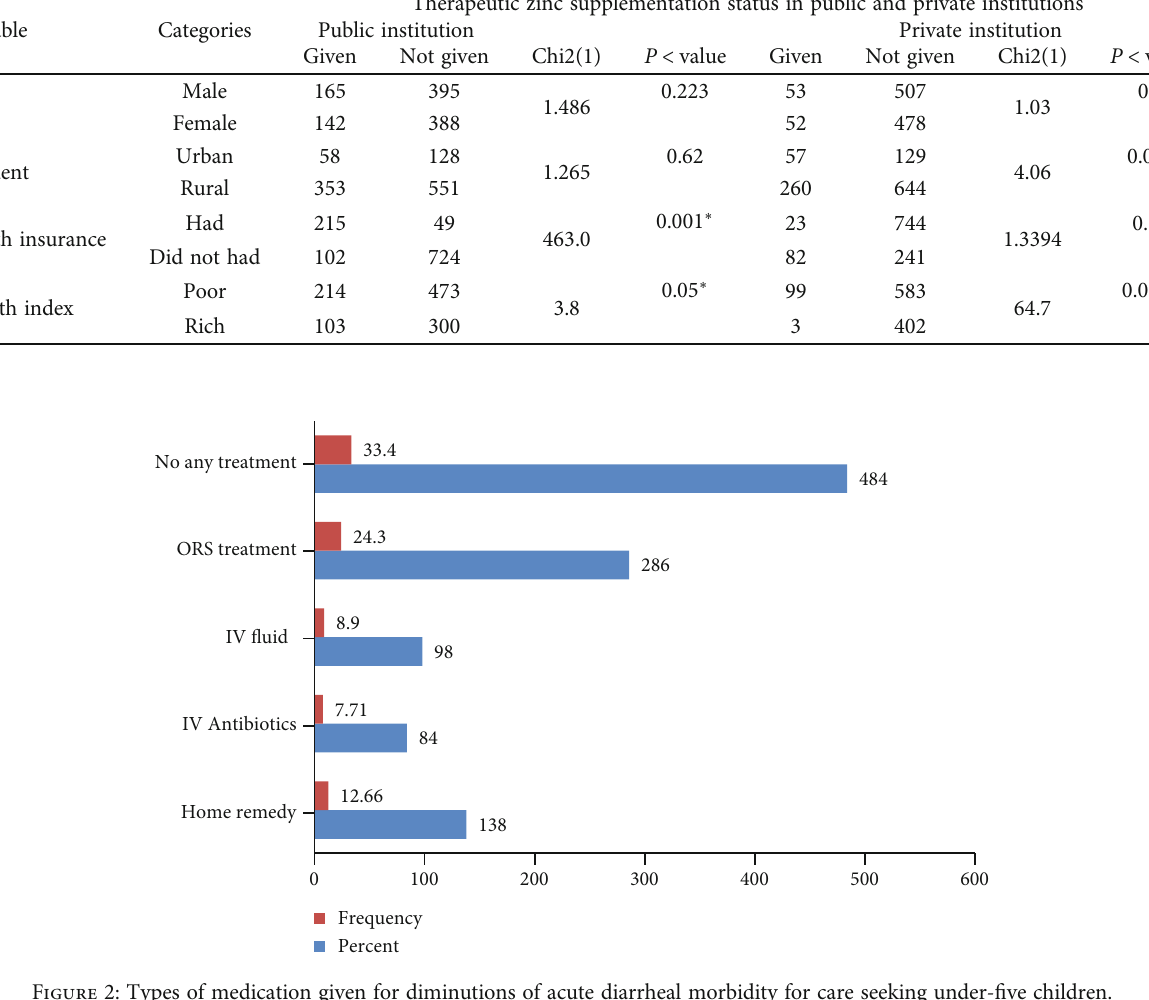
Figure 2: Types of medication given for diminutions of acute diarrheal morbidity for care seeking under- fi ve